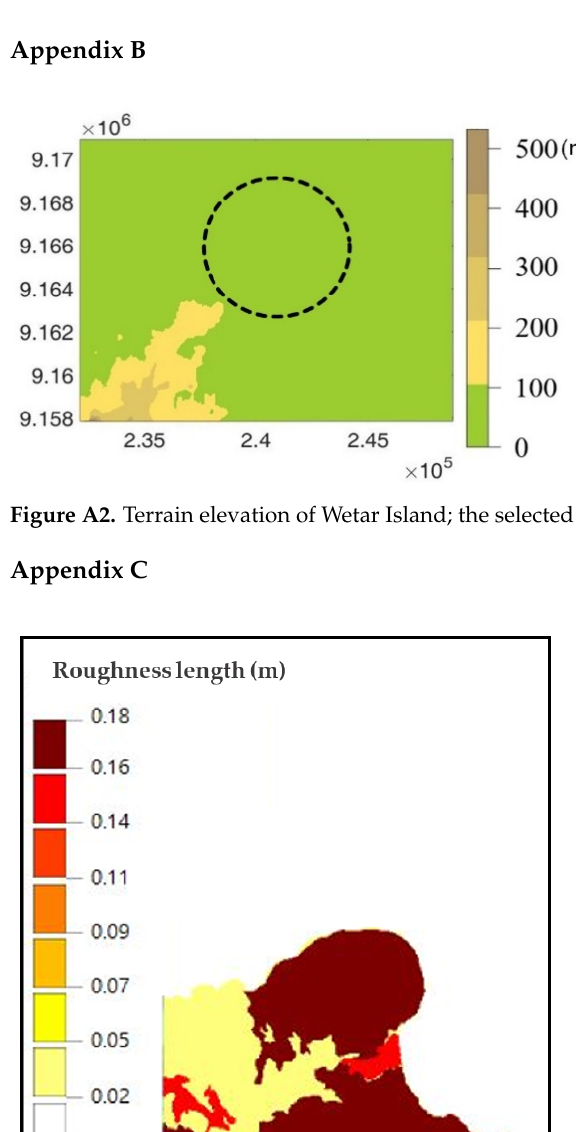
Figure A1. Monthly average wind speed between 2004 and 2015 in the seven evaluated sites.